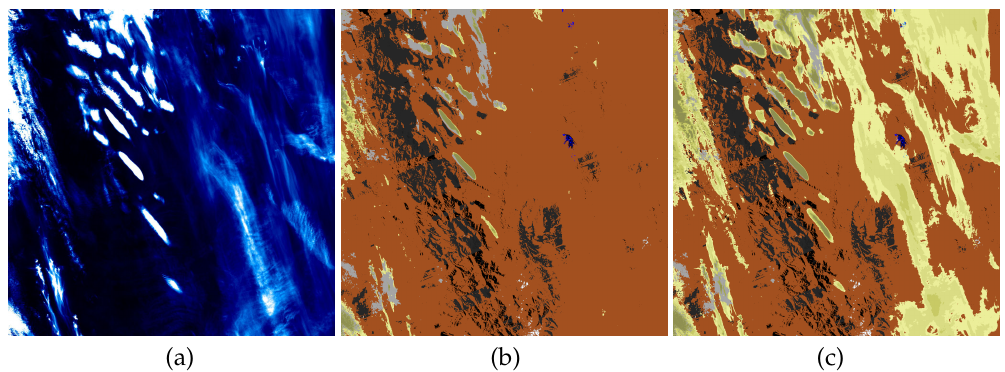
Figure 2. Sentinel-2A scene, Morocco, T29RPQ 18/01/2016 (oriented towards east, see also Figure 3), black: shadow, grey: water cloud, blue: water, light-to-darker yellow: increasing cirrus thickness.